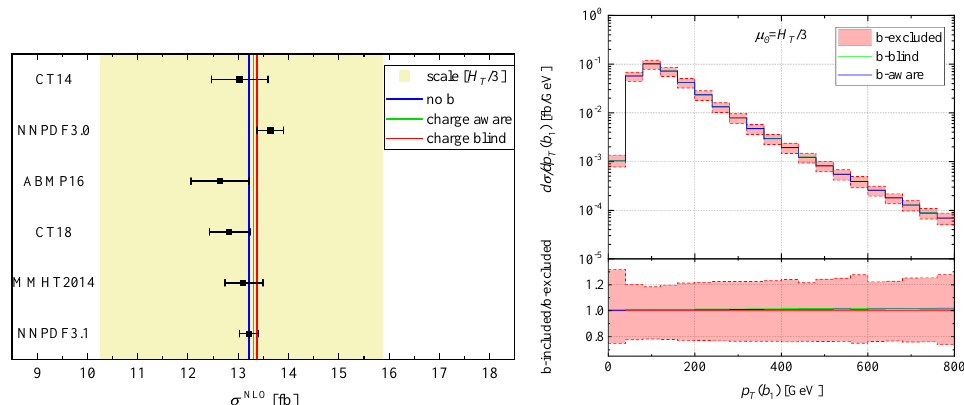
Figure 3: Comparison of the predictions including and excluding b -quarks from the initial state. The left plot reports the results for the integrated fiducial cross sec- tion, where also scale and pdf uncertainties are displayed. The right plot shows the comparison at the differential level for the transverse momentum distribution of the hardest b